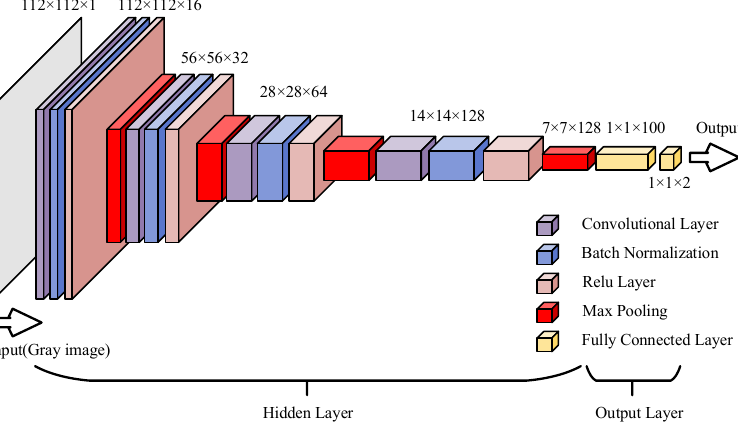
Figure 6. Structure of M-CNN.